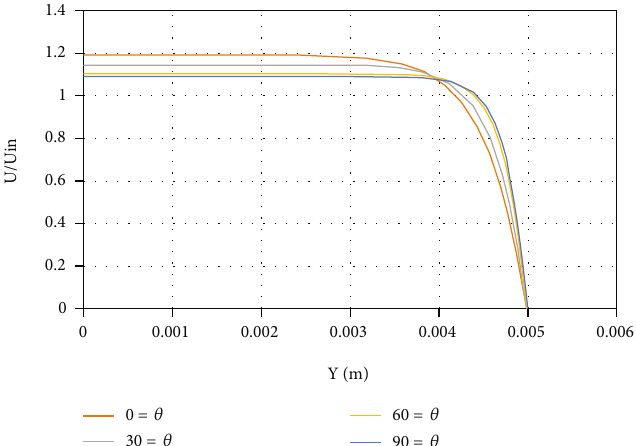
Figure 11: Dimensional dimensionless speed versus cylinder radius ratio for di ff erent magnetic fi eld angles for Al